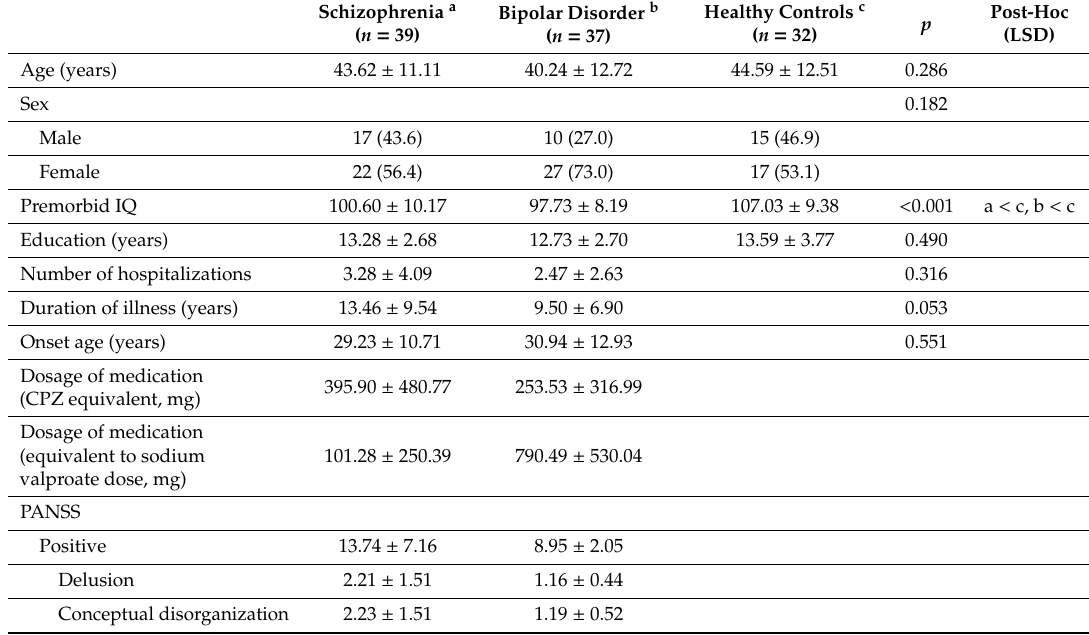
Table 1. Demographic characteristics of all study